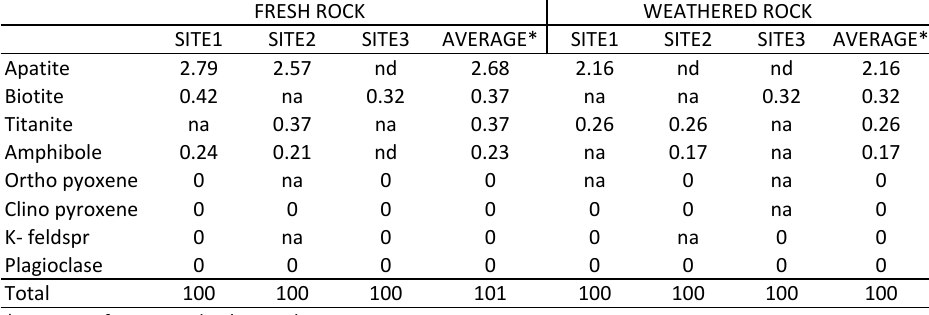
Table 3: Relative abundance of minerals in fresh and weathered rock at different sites (%) FRESH ROCK